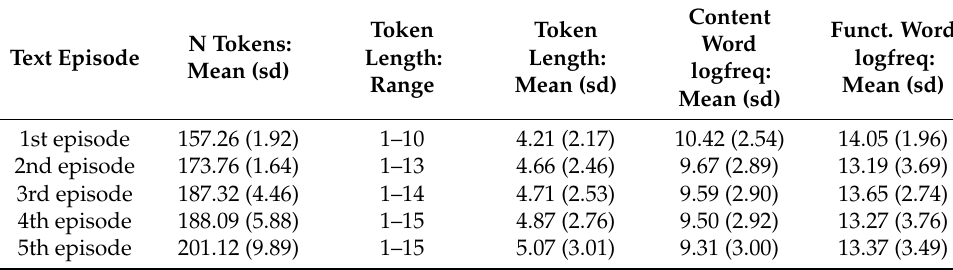
Table 3. Detailed statistics for experimental input per episode averaged over the 4 narrative